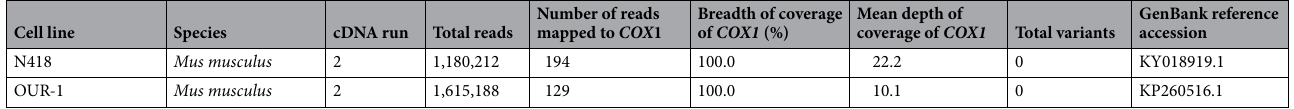
Table 1. Cell lines with species identity determined by sequencing that matched institute records or were previously unknown. Threshold for coverage depth for calling breadth and depth of coverage was set to 3, while the minimum variant frequency = 0.75.